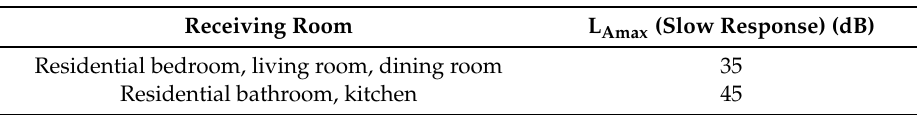
Table 4. Recommended maximum A-weighted SPL for various transient plumbing-noise sources in buildings (ASHRAE